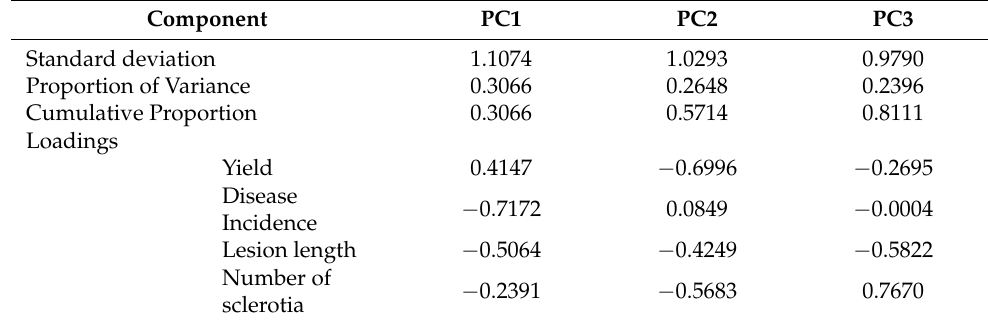
Figure 5. AMMI biplots showing ( A ) IPCA1 vs. IPCA2 and ( B ) additive effects vs. IPCA1 in four canola varieties (ATR Mako, ATR Bonito, Hyola 559TT and Invigor T4510) from 18 sites across (2018–2020). Two management treatments were applied; no fungicide (control) and fungicide at 30% flowering (sprayed). Table 5. Eigenvalues, percentage variation and component loadings following Principal Components Analysis (PCA) of 246 diseased plots from 16 sites across four growing seasons